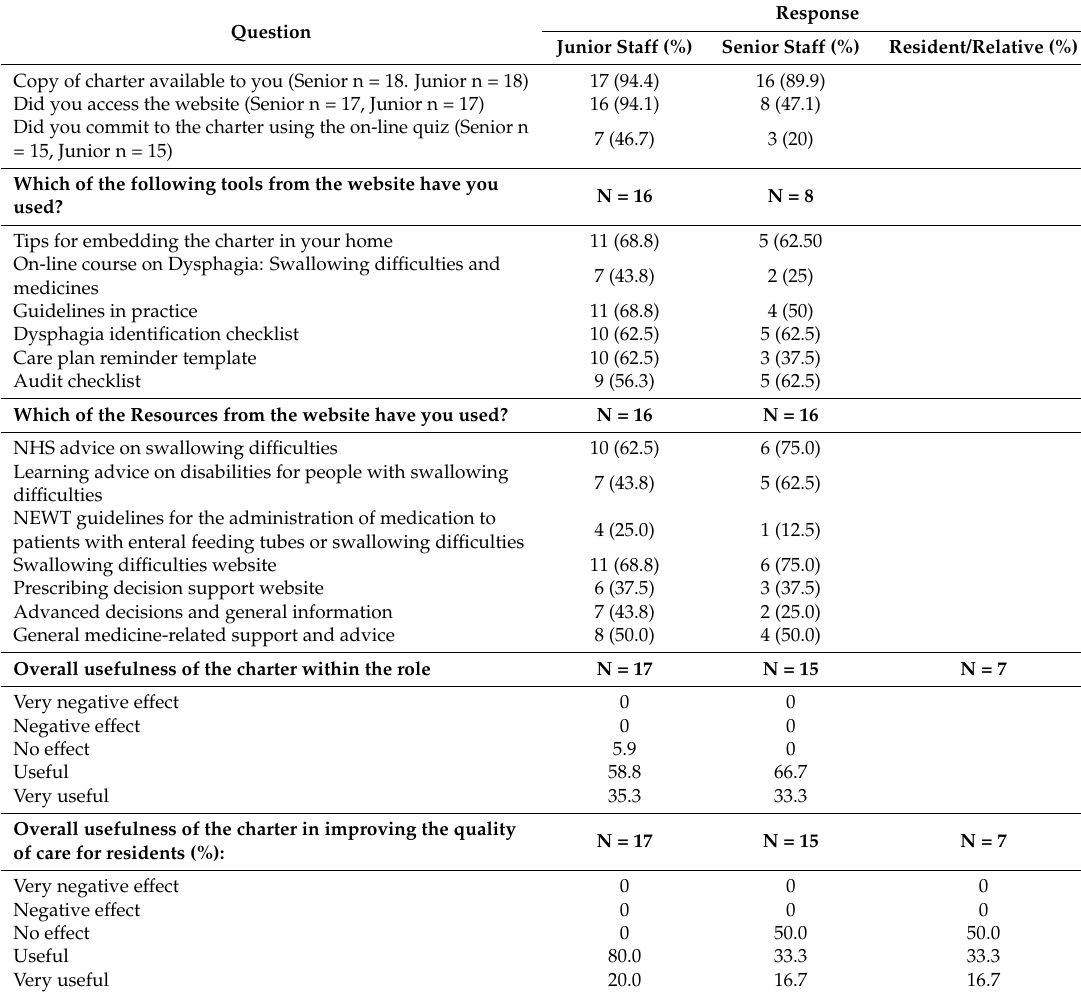
Table 2. Respondent summary of how the charter and website has been implemented and the perceived effect on staff and relatives/residents. Response Question Junior Staff (%) Senior Staff